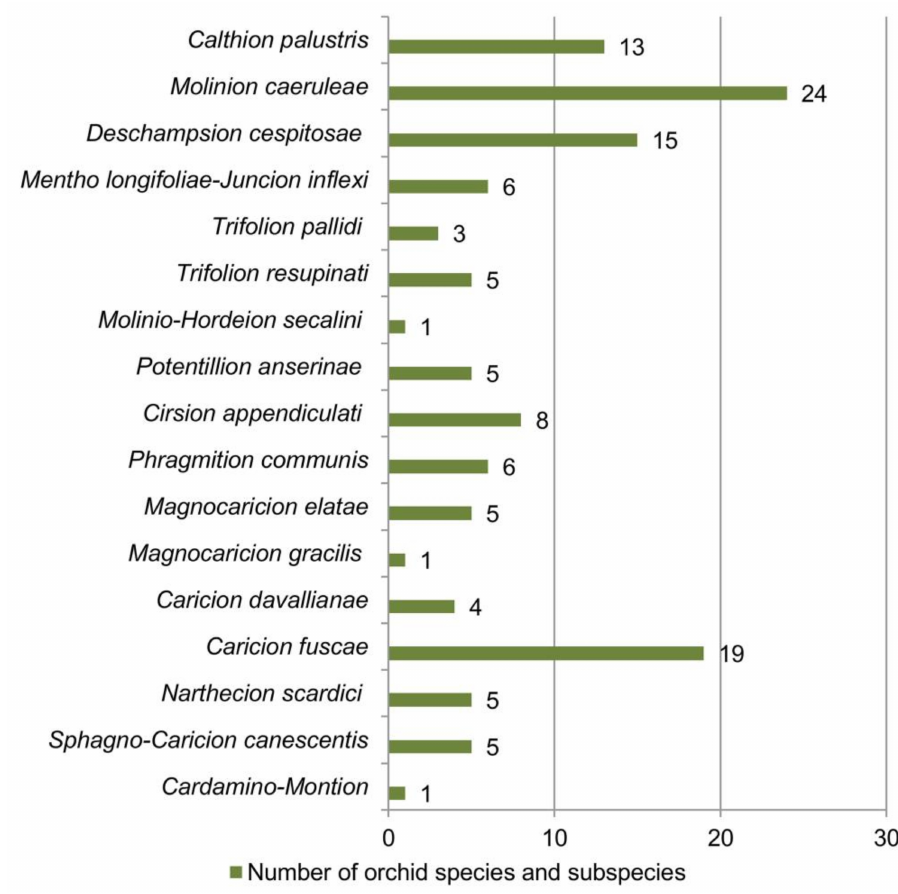
Figure 8. Richness of orchid species and subspecies in relation to vegetation alliances. Concerning vegetation orders, the greatest number of orchids was recorded in the Molinietalia caeruleae (26 taxa or 78.8% of the total analyzed orchid flora), followed